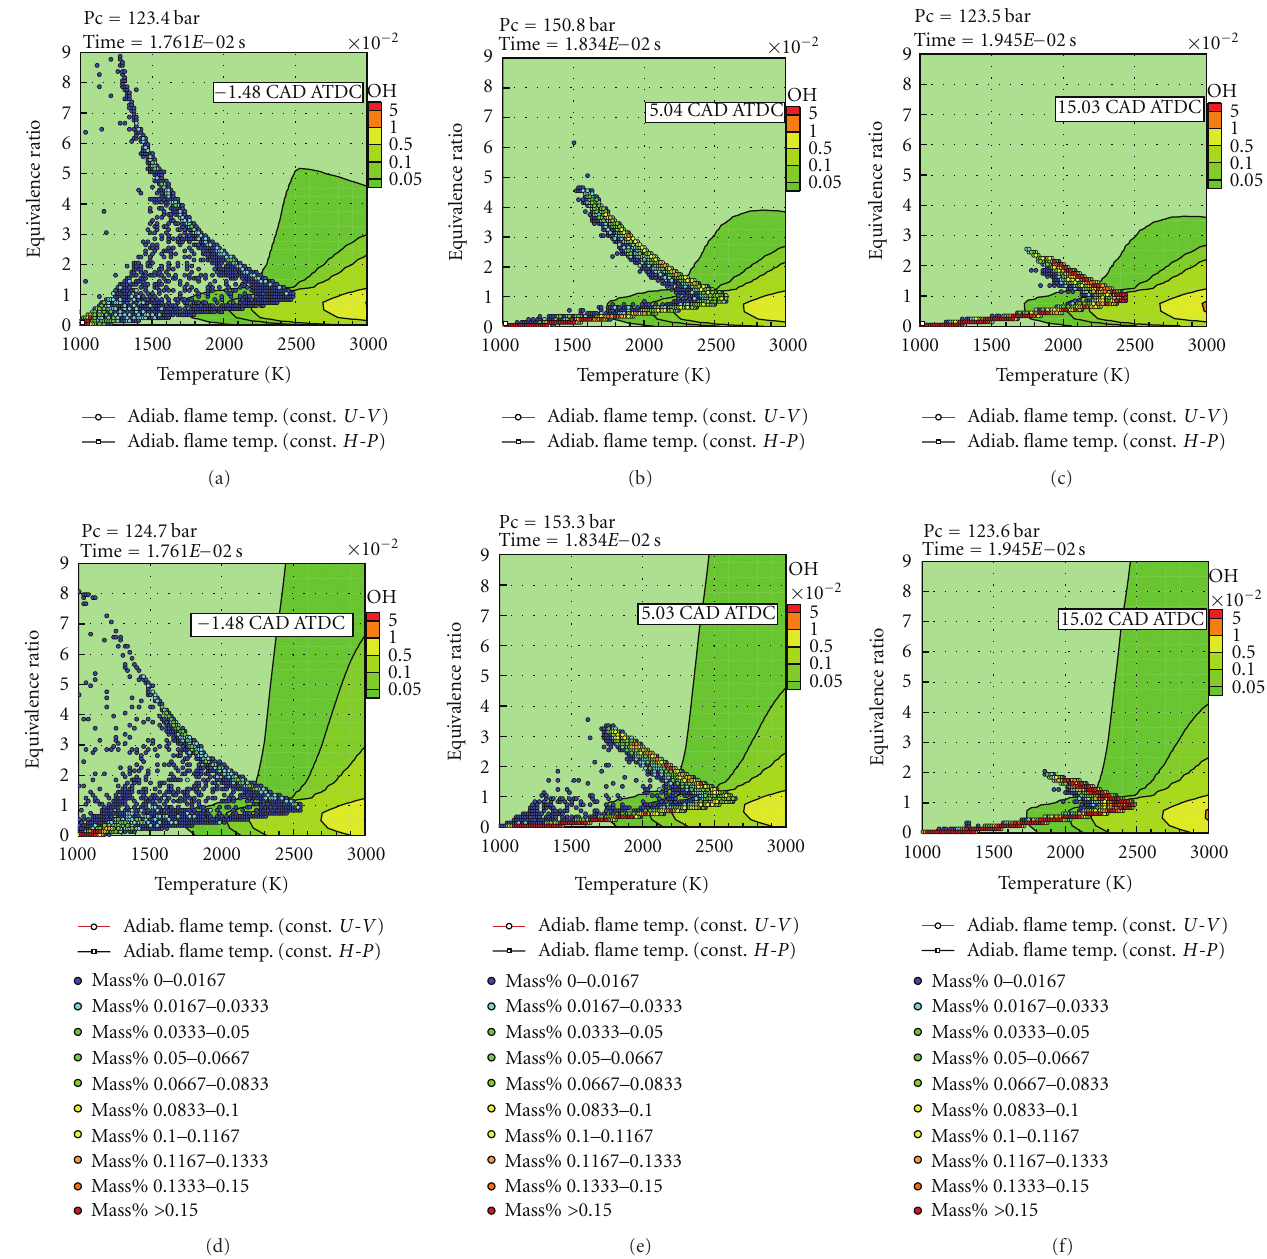
Figure 17: Parametric φ - T maps for instant OH concentrations in the Volvo D12C Diesel engine fuelled by DOS (a, b, and c) and RME (d, e, and f) at di ff erent CADs ( − 1.5, 5.0, and 15.0, resp.); the engine was operated under 50% load with 30% EGR.